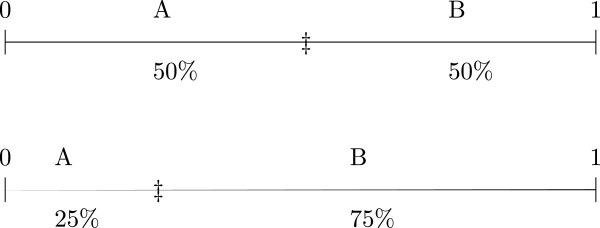
Probability boundaries for a two group randomization. First group is a 1:1 allocation to either group at a point where there are equal numbers in each group. The second is an example of a 1:3 allocation in favour of group B.